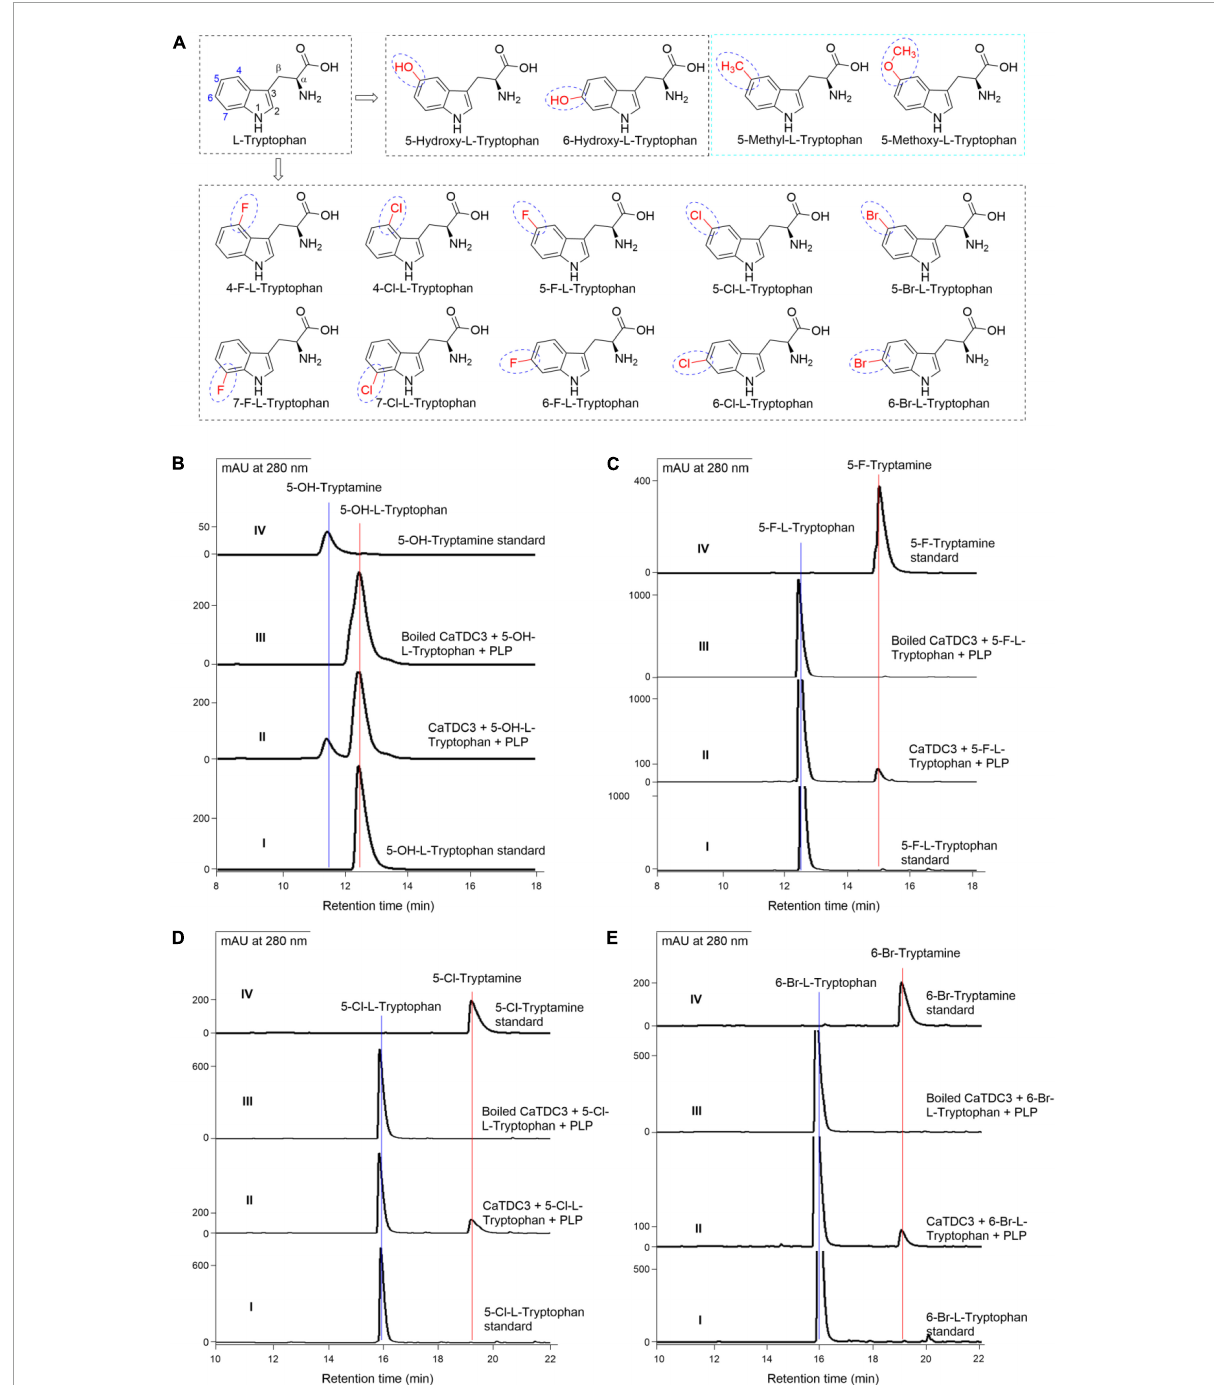
FIGURE8 The effects of substituent groups at the indole ring of L-tryptophan on CaTDC3’s decarboxylative activity. Chemical structure of L-tryptophan analogs with diverse substituent groups at the indole ring tested in the present work (A) . (B) HPLC-DAD analyses of authentic 5-hydroxy-L-tryptophan (panel I), the enzymatic reaction mixture with CaTDC3 (panel II), and boiled CaTDC3 (panel III) as catalyst, respectively, and the standard 5-hydroxytryptamine (panel IV). (C) HPLC-DAD analyses of the standard 5-fluoro-L-tryptophan (panel I), the enzymatic reaction mixture with CaTDC3 (panel II), and boiled CaTDC3 (panel III) as catalyst, respectively, and the standard 5-fluorotryptamine (panel IV). (D) HPLC-DAD analyses of the standard 5-chloro-L-tryptophan (panel I), the enzymatic reaction mixture with CaTDC3 (panel II), and boiled CaTDC3 (panel III) as catalyst, respectively, and the standard 5-chlorotryptamine (panel IV). (E) HPLC-DAD analyses of the standard 6-bromo-L-tryptophan (panel I), the enzymatic reaction mixture with CaTDC3 (panel II), and boiled CaTDC3 (panel III) as catalyst, respectively, and the standard 6-bromotryptamine (panel